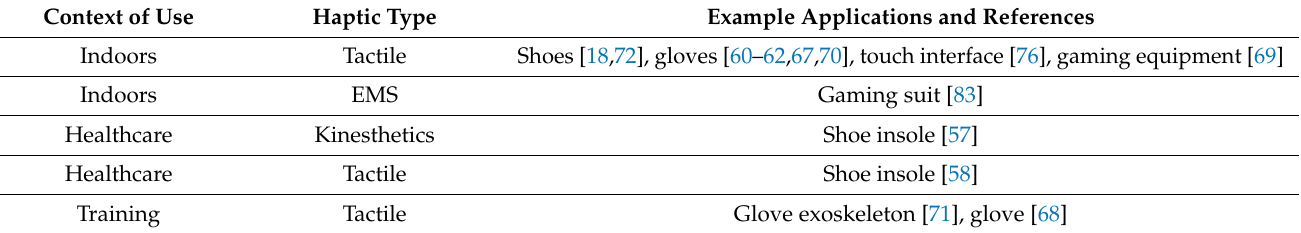
Table 4. Contexts of use for commercial haptic